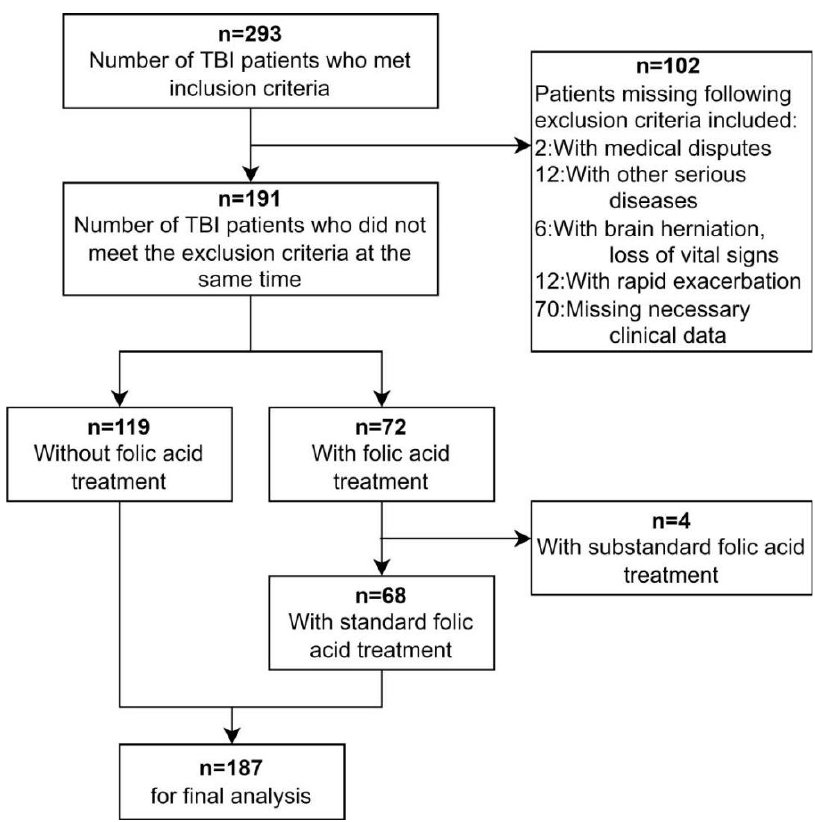
Figure 2. Flowchart for patient inclusion. Table 1. Clinical information of overall TBI patients, folic acid treatment and non-folic acid treatment group patients.